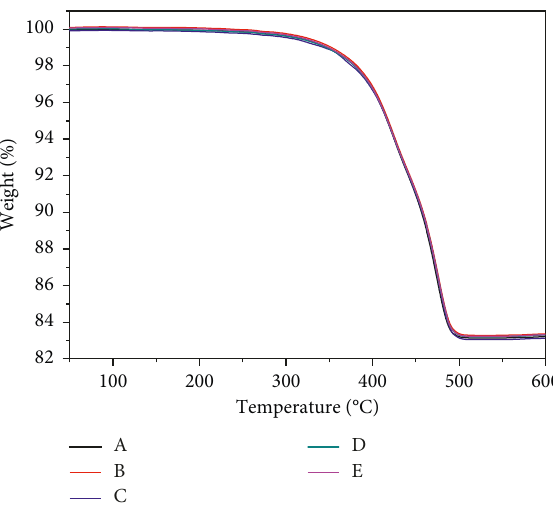
Figure 9: Viscosity and torque values of the feedstock B17 at 150 ° C.